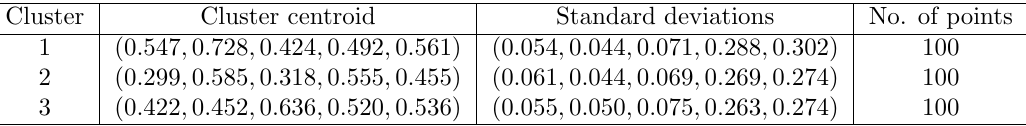
Table 1. Centroid and Standard Deviations of Clusters in Different